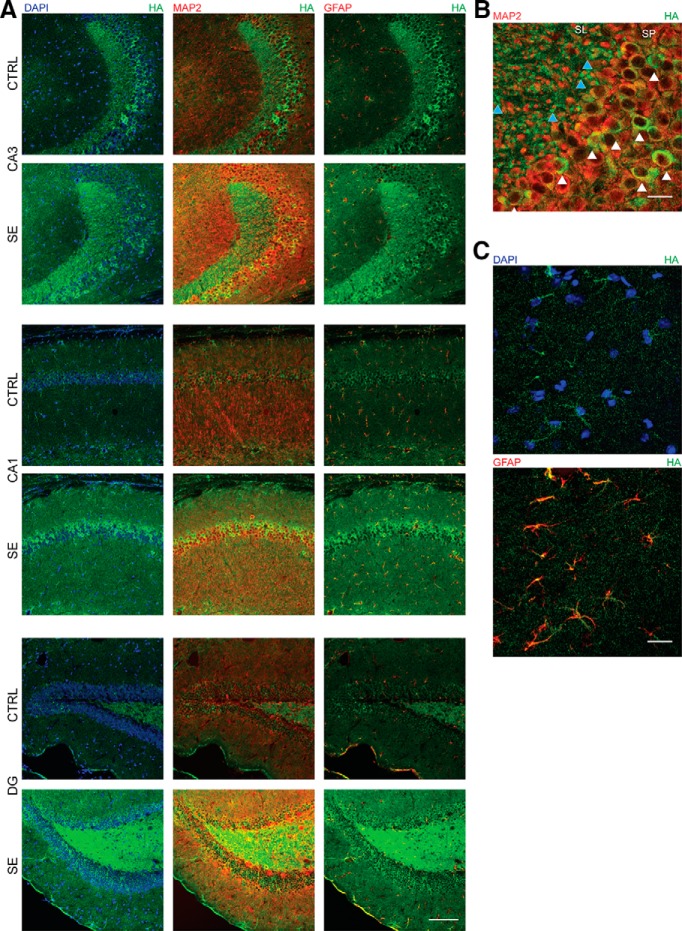
BDNF protein is expressed in neurons and astrocytes of hippocampus after pilocarpine-induced SE. A, Representative confocal images of hippocampal subfields from HA-tagged mice 3 h after SE and an age- and handling-matched control (20× magnification; scale bar, 100 µm) shows the presence of HA immunoreactivity in principal cells, glia, and mossy fiber layers. The first column shows anti-HA (green) immunoreactivity with DAPI (blue) in each condition. The second column demonstrates the colocalization of immunoreactivity for HA (green) and the neuronal marker MAP2 (red). The third column demonstrates colocalization of immunoreactivity for HA (green) and the glial marker GFAP (red). B, High-magnification confocal image of CA3 hippocampal subfield (63× magnification; scale bar, 20 µm). White arrowheads correspond to neuronal localization of HA immunoreactivity in pyramidal cells of CA3; blue arrowheads correspond to the localization of HA immunoreactivity in mossy fibers. SL, Stratum lucidum; SP, stratum pyramidale. C, High-magnification confocal image of CA3 hippocampal subfield (63× magnification; scale bar, 20 µm), demonstrating glial expression of BDNF.